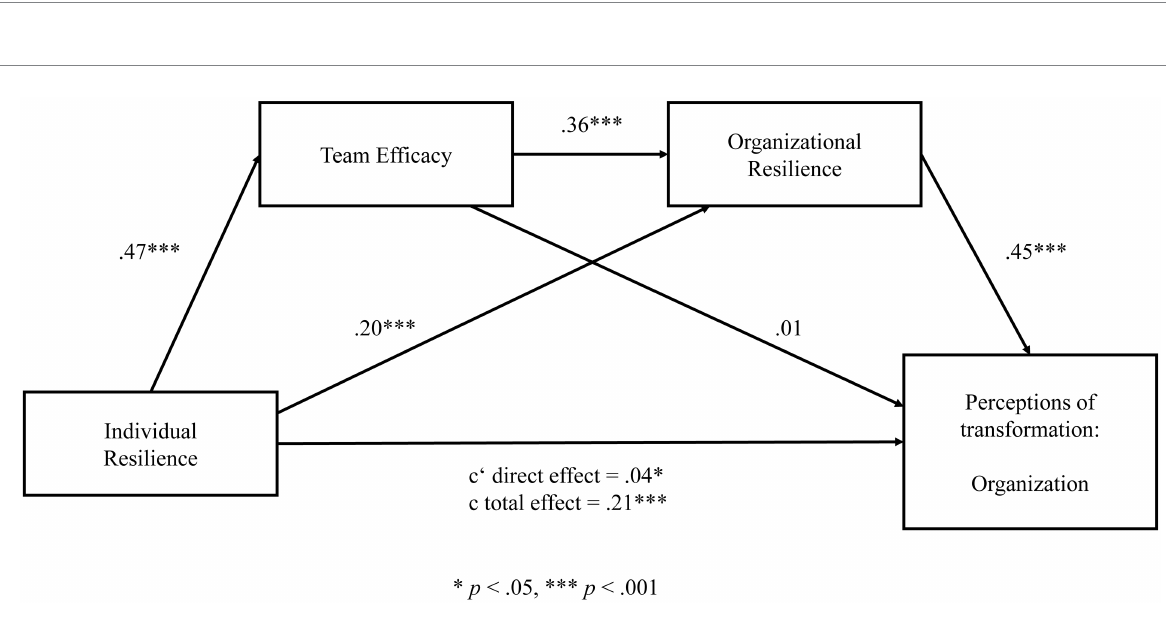
FIGURE 4 Sequential mediation model for perceptions of transformation on the organizational level. Significant at level * p < 0.05, *** p < 0.001.